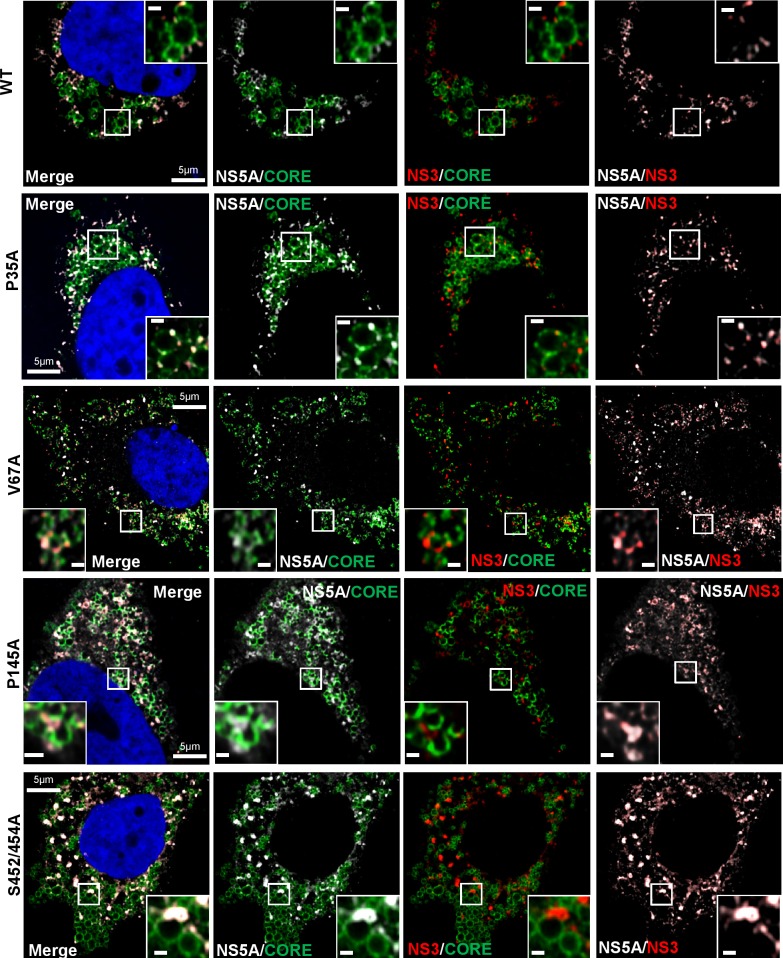
Co-localisation of NS5A, Core and NS3 in infected cells.Huh7.5 cells were electroporated with in vitro transcripts of mJFH-1 WT or the indicated mutants. At 72 h.p.e. cells were fixed and stained with anti-NS5A, NS3 and Core antibodies, and counterstained with DAPI, prior to imaging by Airyscan microscopy. The scale bars are 5 μm and 0.5 μm, respectively.